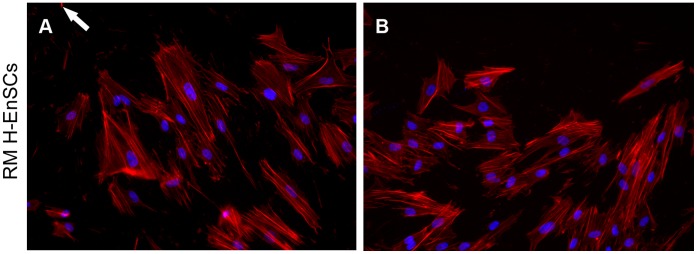
F-Actin architecture in H-EnSCs in the presence and absence of a trophoblast spheroid.In a confluent well of a 48-well plate a migration zone was created. Decidualized H-EnSCs of a RM patient were left to migrate in the presence (A) or absence (B) of a trophoblast spheroid consisting of 3000 cells. The white arrow in panel A indicates the position of the trophoblast spheroid. Both micrographs were obtained from the same location in the well. Cells were fixed and stained for F-actin (red) and DNA was stained with DAPI (blue). Magnification: ×20.